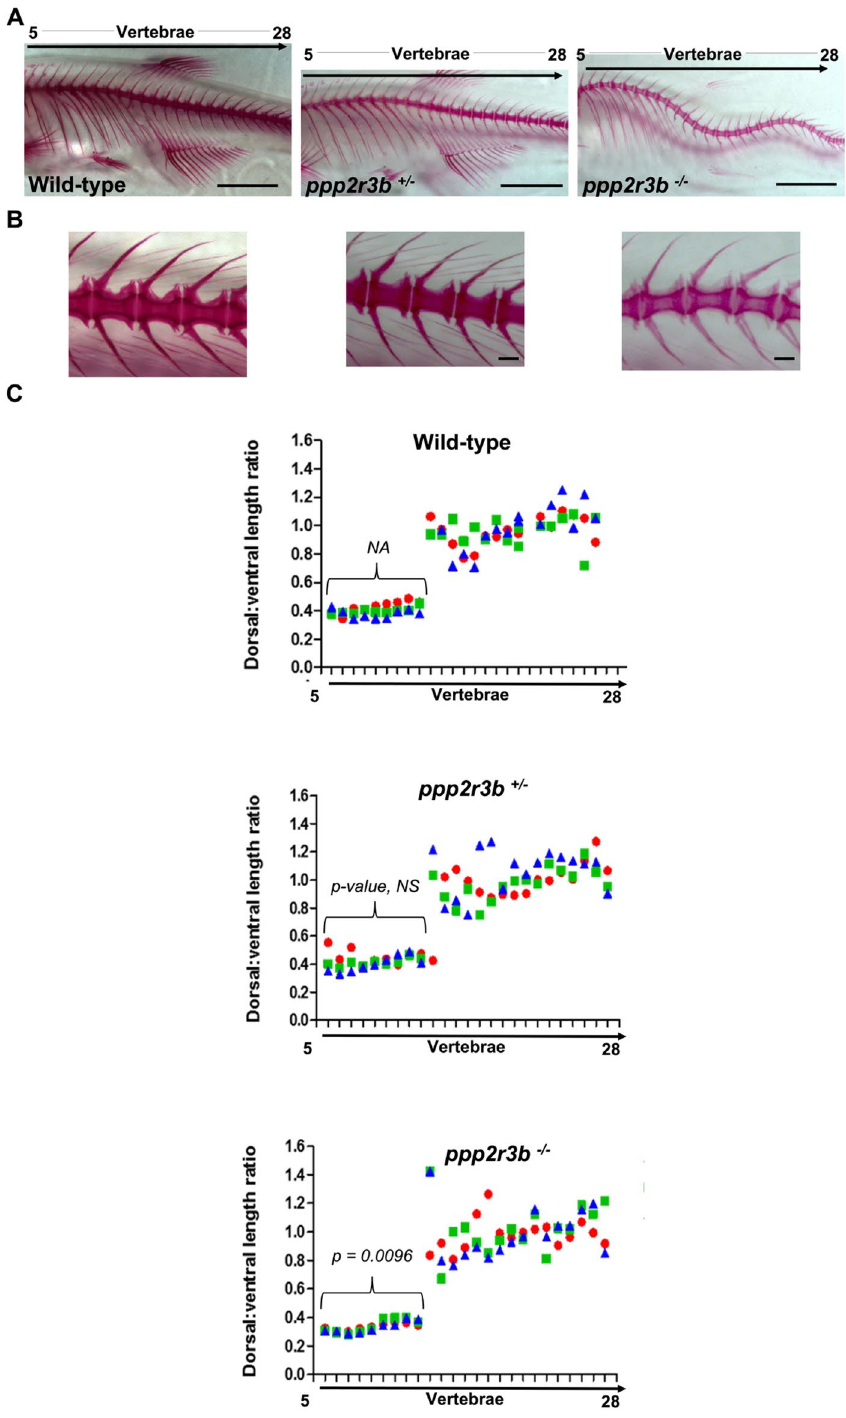
Figure 8. Morphometric analysis of mineralised bone. ( A , B ) Alizarin red staining of vertebrae 36 dpf zebrafish of the indicated genotypes. ( C ) Quantification of the neural spine:hemal spine/rib length ratios for vertebrae 5–28. Data-points for individual animals are indicated by different colours. Mean ± standard deviation of values of these ratios averaged across all ribs for each animal, indicated by the brackets, and subsequently averaged over three animals are 0.401 ± 0.024, 0.423 ± 0.029 and 0.335 ± 0.005 for wild-type, heterozygous and homozygous mutant animals, respectively (n = 3 animals). P-values compared to wild-type are indicated. This represents a statistically significant difference in homozygotes versus each of the other two genotypes ( t-test ). Tail lengths taking into account spinal curvature were 12.694, 12.872 and 12.749 mm for the representative wild-type, ppp2r3b + /− and ppp2r3b−/− animals shown, respectively. All animals are generation F4. Scale bars are 5 mm in ( A ); 2 mm in ( B